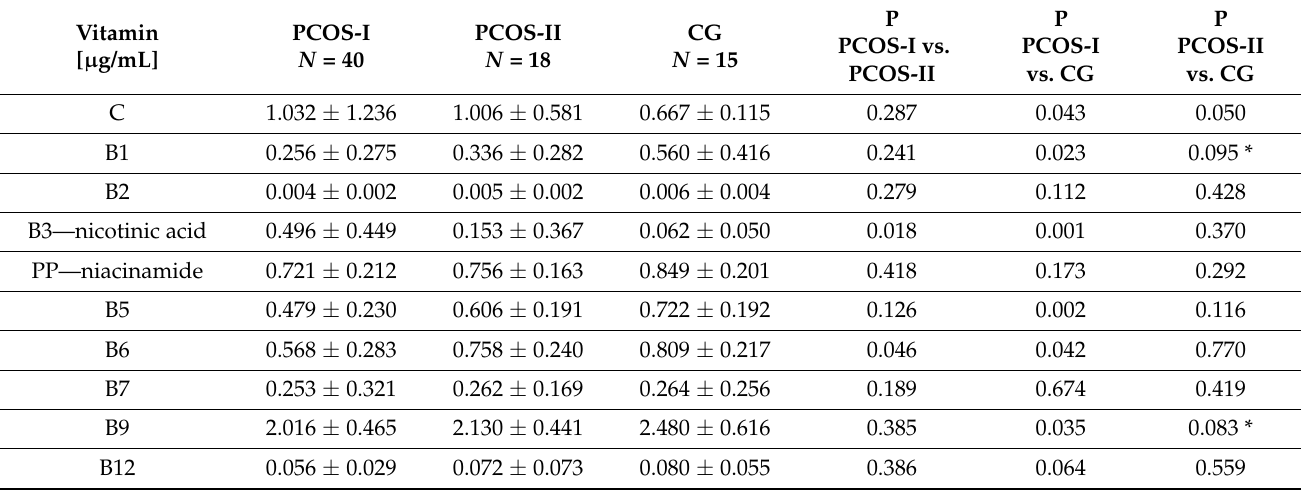
Table 3. The average concentration of vitamins analysed in the plasma before and after the dietary intervention with reference to the analysed groups (PCOS-I, PCOS-II, and CG).